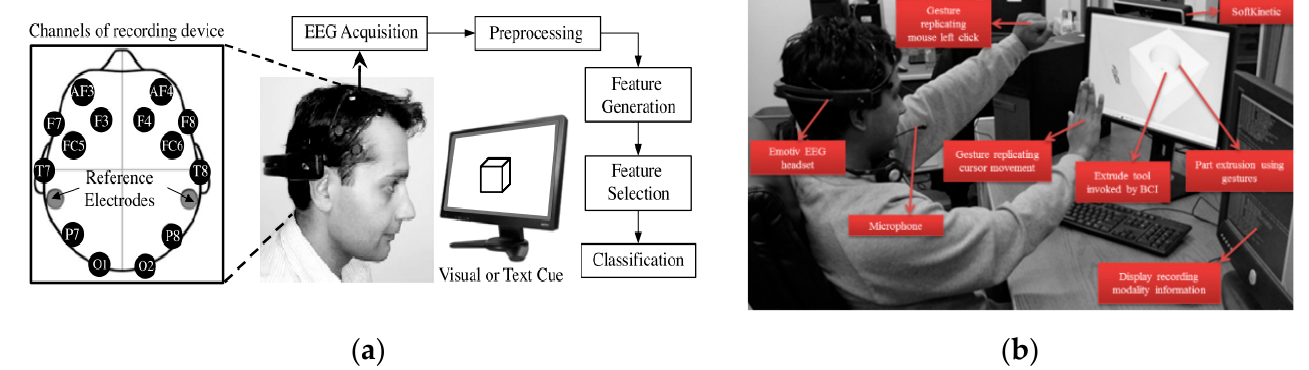
Figure 6. Emotiv used for BCI in CAD applications: ( a ) constructing 3D models from BCI. Reproduced with permission from [58], Elsvier, 2012; ( b ) multimodal interface-based CAD system. Reproduced with permission from [3], ASME, 2013.